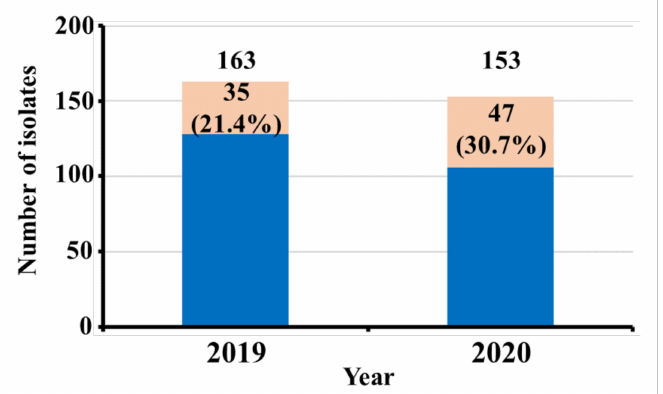
Figure 1. A. baumannii isolation rate among other isolates during the year 2019–2020. Table 2. Comparison of antibiotics sensitivity pattern of A. baumannii isolated from 2019–2020.